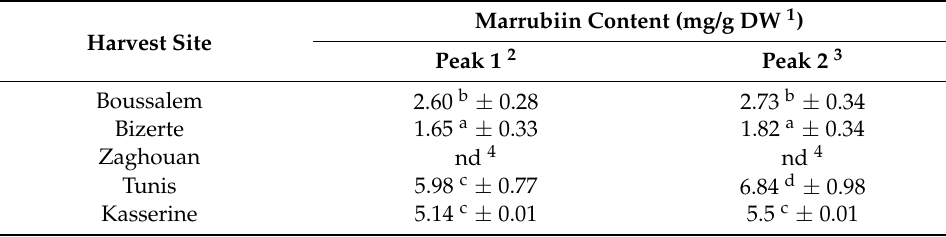
Table 4. Marrubiin content of M.vulgare from different locations *.